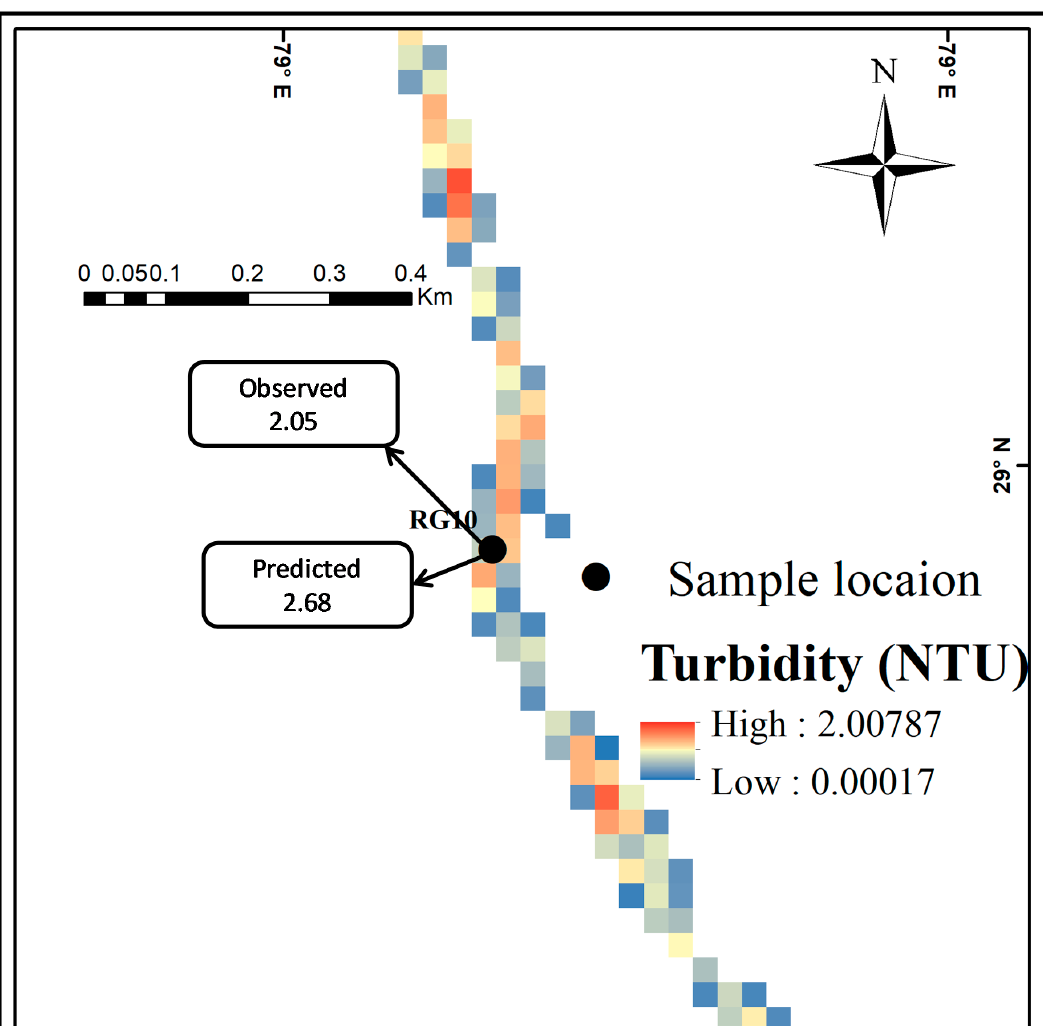
Figure 8. Turbidity map of the Ramganga River on 11 March 2014.